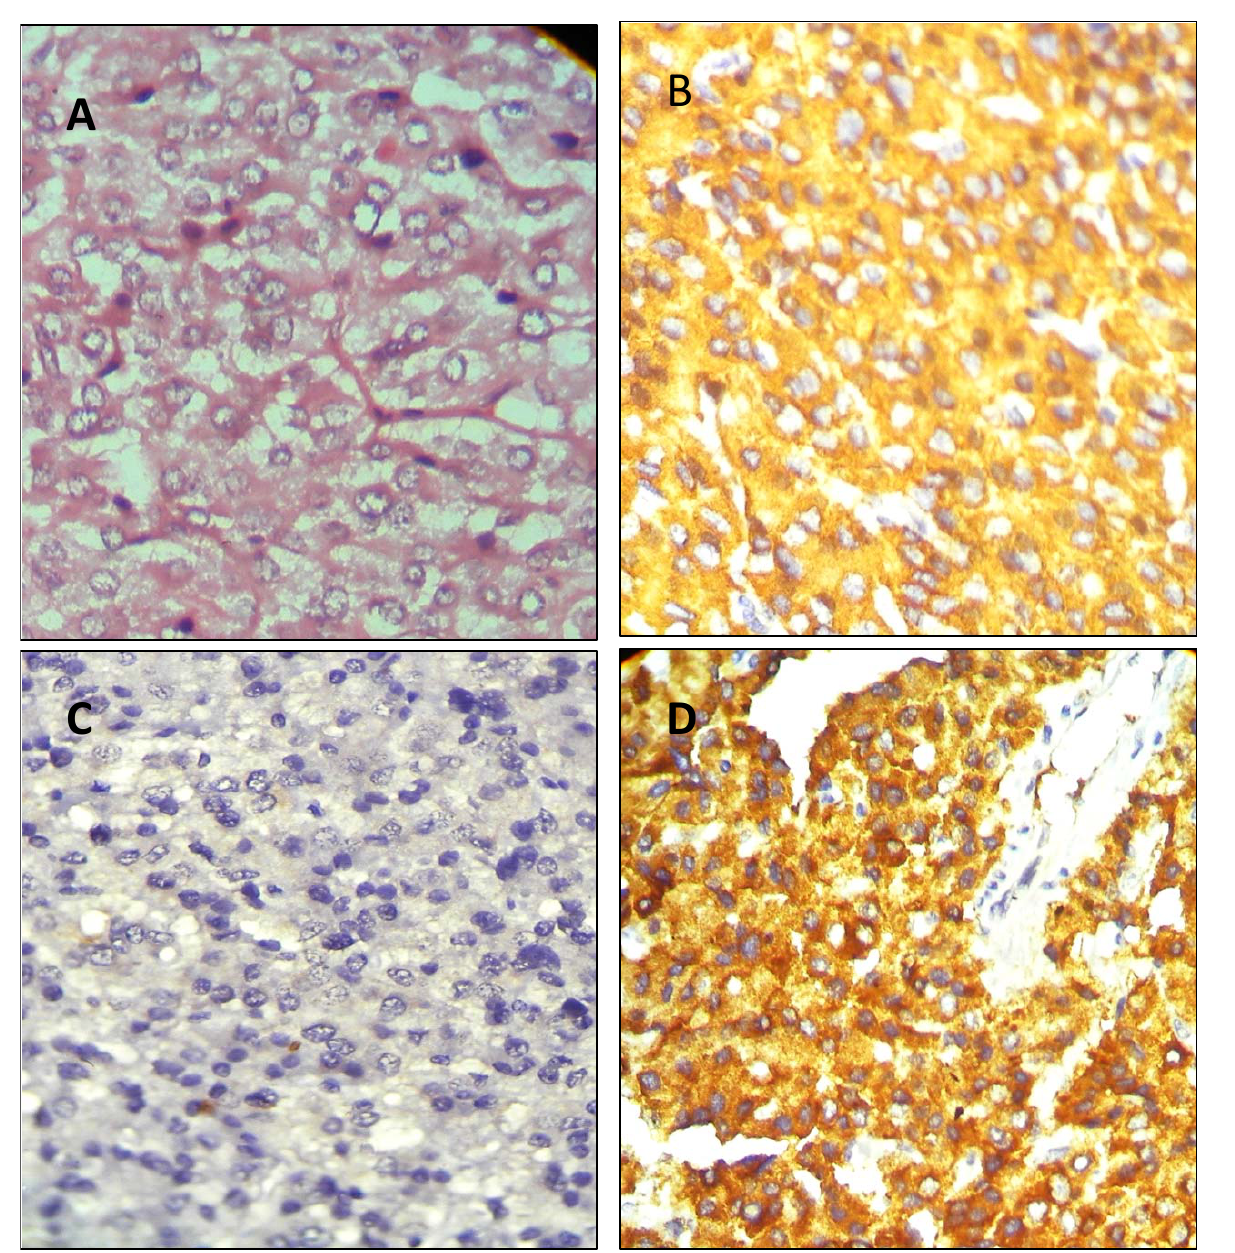
Figure 2. A) H & E section shows tumor cells B) Chromogranin A immunostaining is diffusely positive in the tumor cells. C) Tumour cells negative for cytokeratin (CK) immunostaining. D) Synaptophysin staining shows diffuse cytoplasmic staining in the tumor cells.